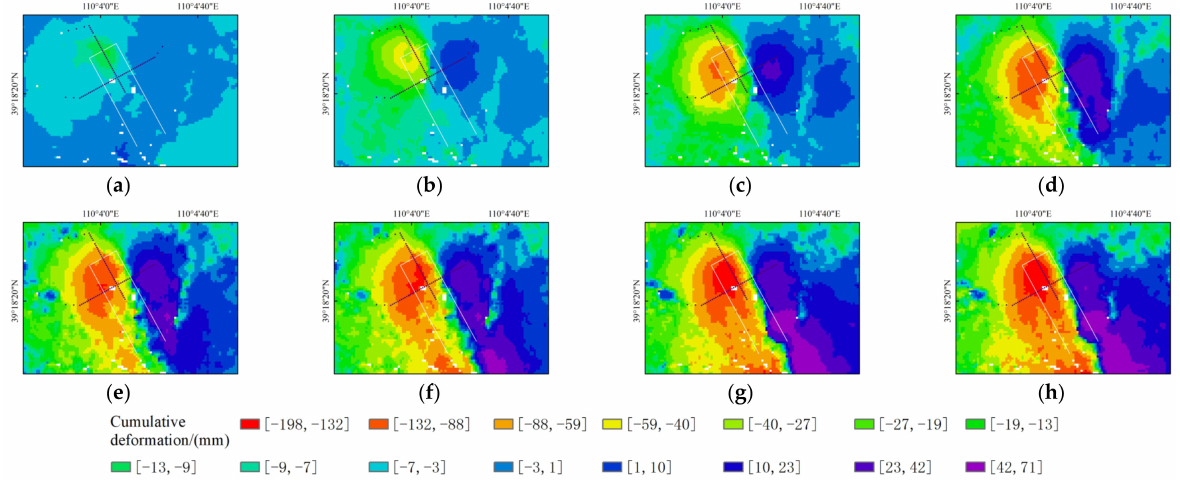
Figure 11. Time-series accumulated settlement of InSAR: ( a ) 12 April 2018, ( b ) 18 May 2018, ( c ) 23 June 2018, ( d ) 29 July 2018, ( e ) 22 August 2018, ( f ) 27 September 2018, ( g ) 18 February 2019, and ( h ) 13 May